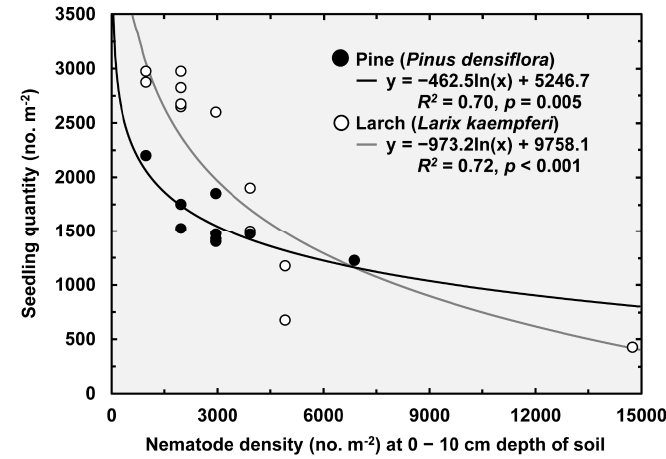
Figure 2. Relationship between soil nematode density and the quantity of pine and larch seedlings in the open-field nursery.